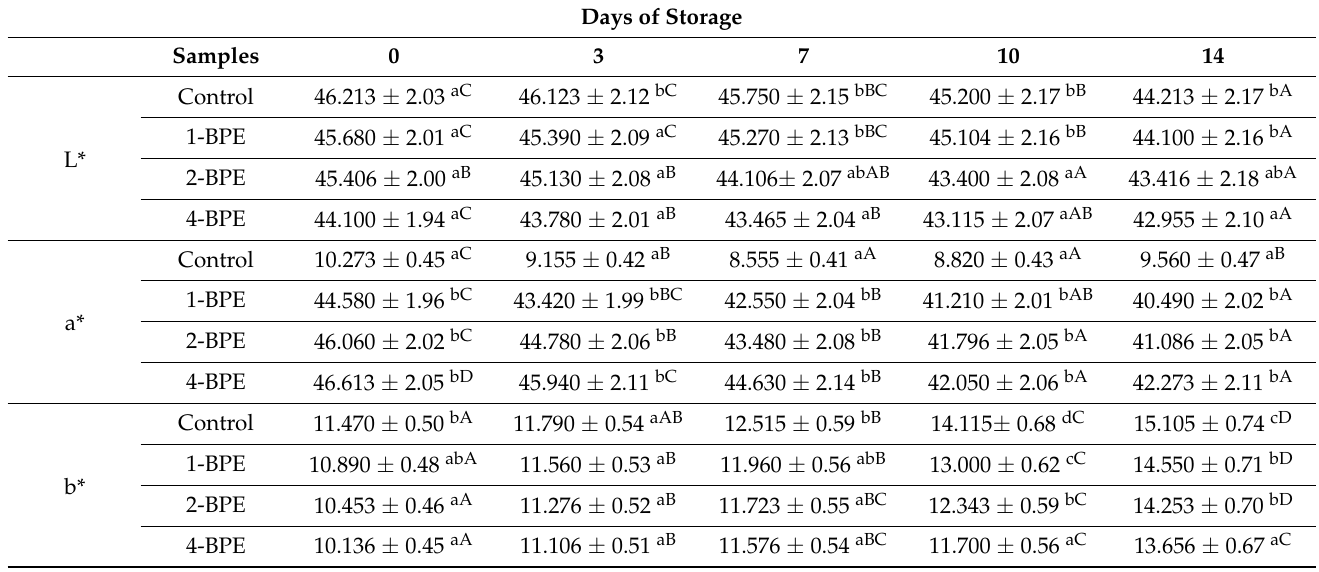
Table 8. Color parameters (L*, a*, and b* ) of packaged raw minced meat samples stored at 4 ◦ C for 14 days. Days of